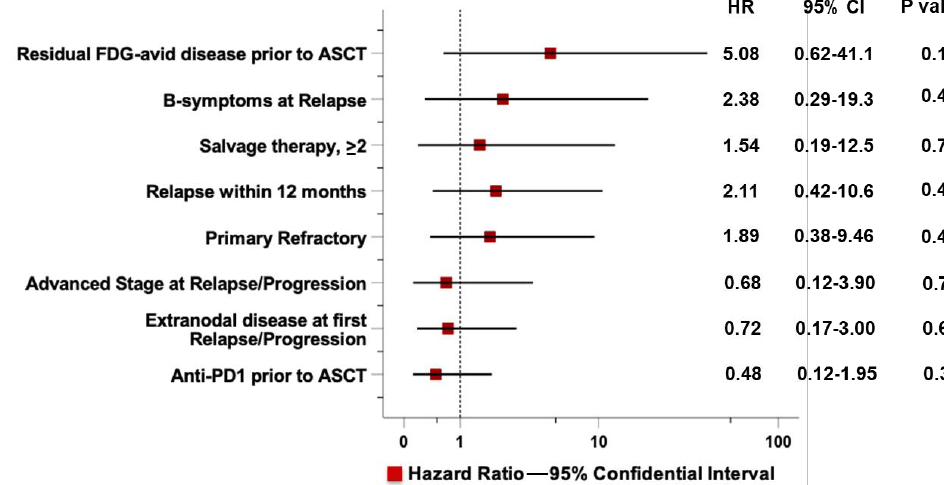
Figure 2. Cox univariate analyses of progression-free survival for 26 high-risk patients with RR-HL who received PD1-blockade after autologous stem cell transplantation (ASCT). The Forest plot summarizes the Cox univariate analysis for risk factors associated with post-ASCT progression.